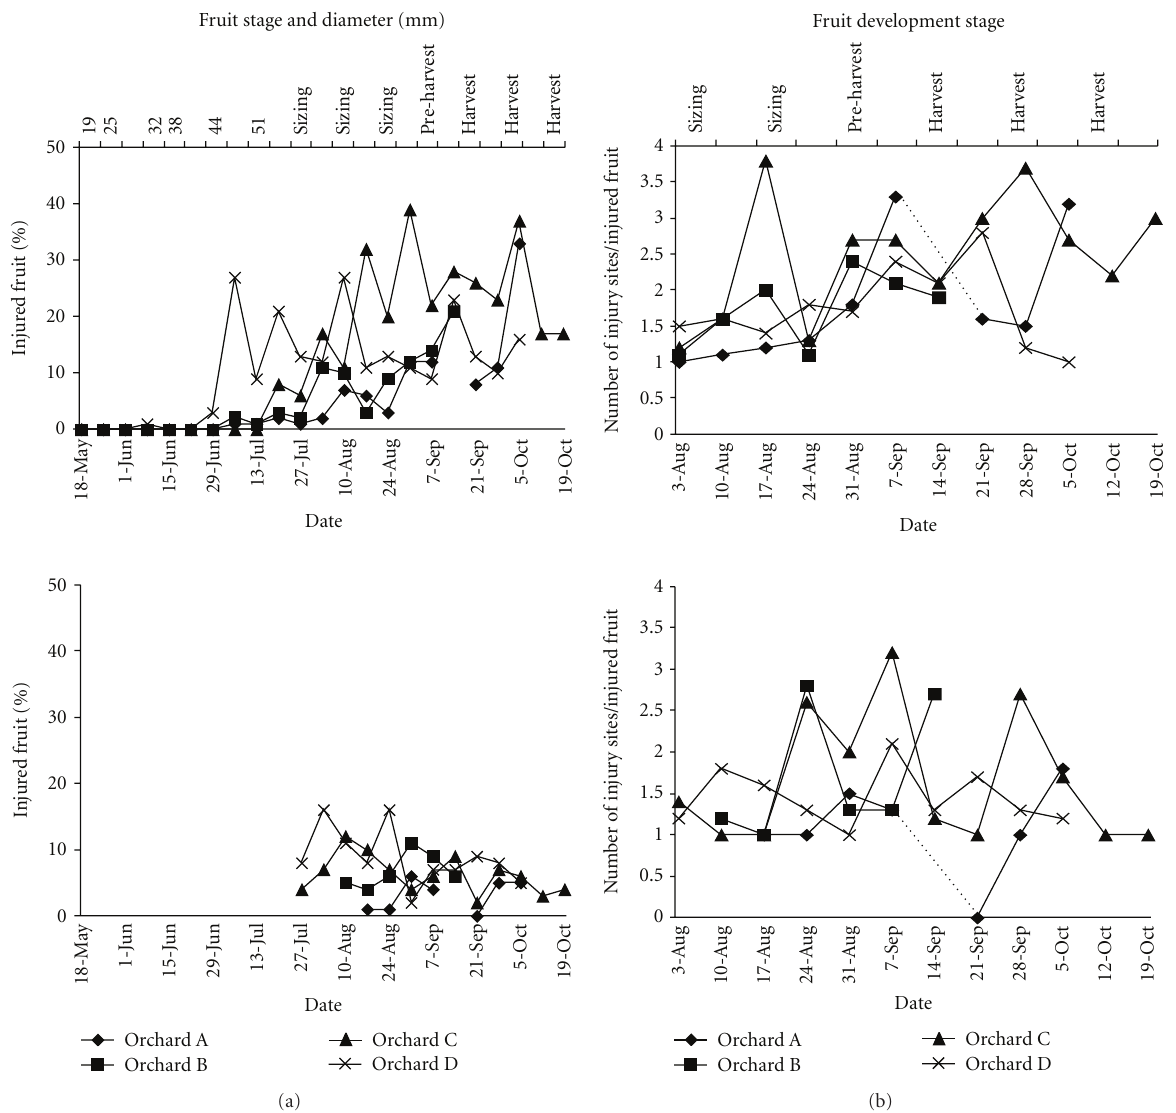
Figure 8: (a) Percent injured apples in 2011 at orchards A–D from the plot exterior (top) and interior (bottom) and (b) the number of injury sites per injured fruit in 2011 at orchards A–D in the plot exterior (top) and interior (bottom). Note: the dotted lines in 8B represent missing data on 14